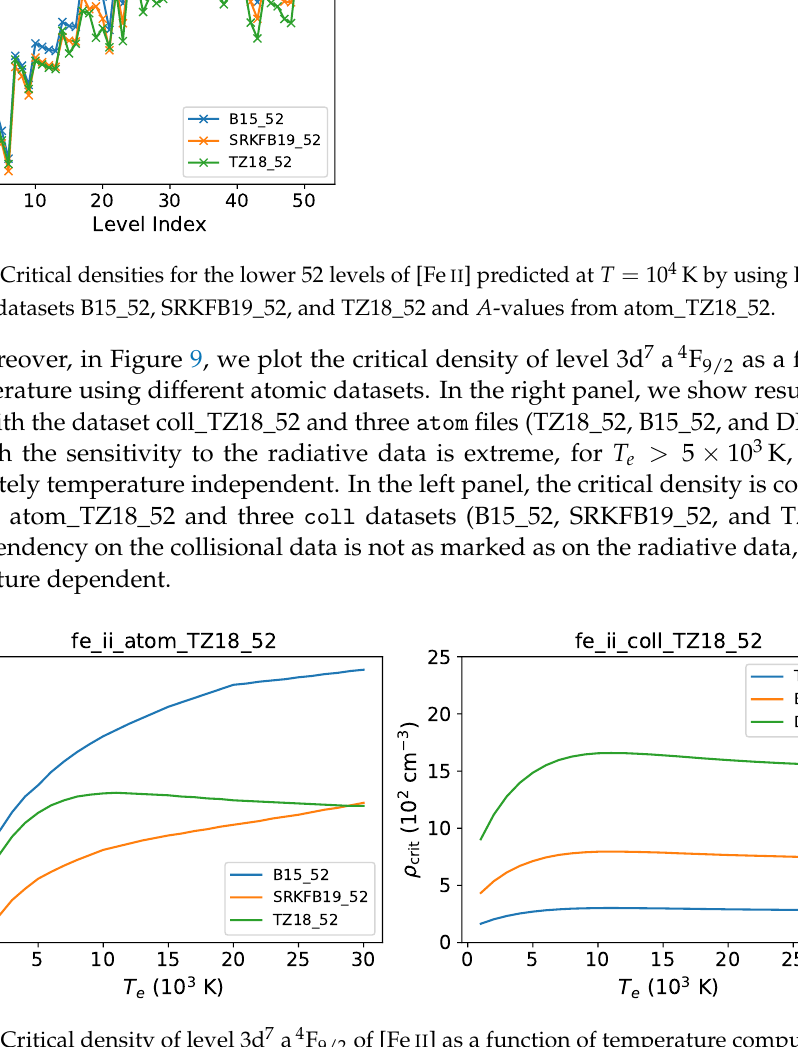
Figure 9. Critical density of level 3d 7 a 4 F 9/2 of [Fe II ] as a function of temperature computed with different atomic datasets. Left panel : atom_TZ18_52 file and three coll files: B15_52, SRKFB19_52, and TZ18_52. Right panel : coll_TZ18_52 file and three atom files: TZ18_52, B15_52, and